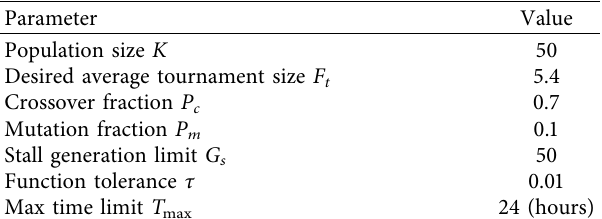
Table 2: The parameters of